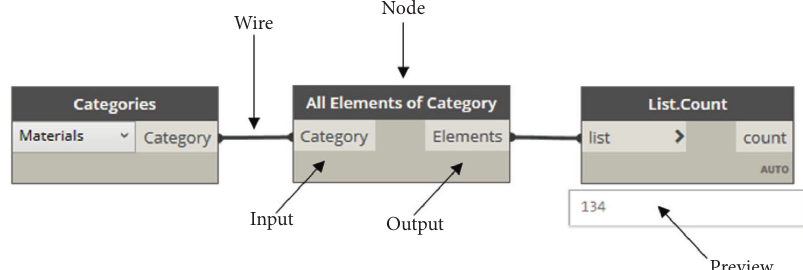
Figure 7: Structure of Dynamo visual programming language.